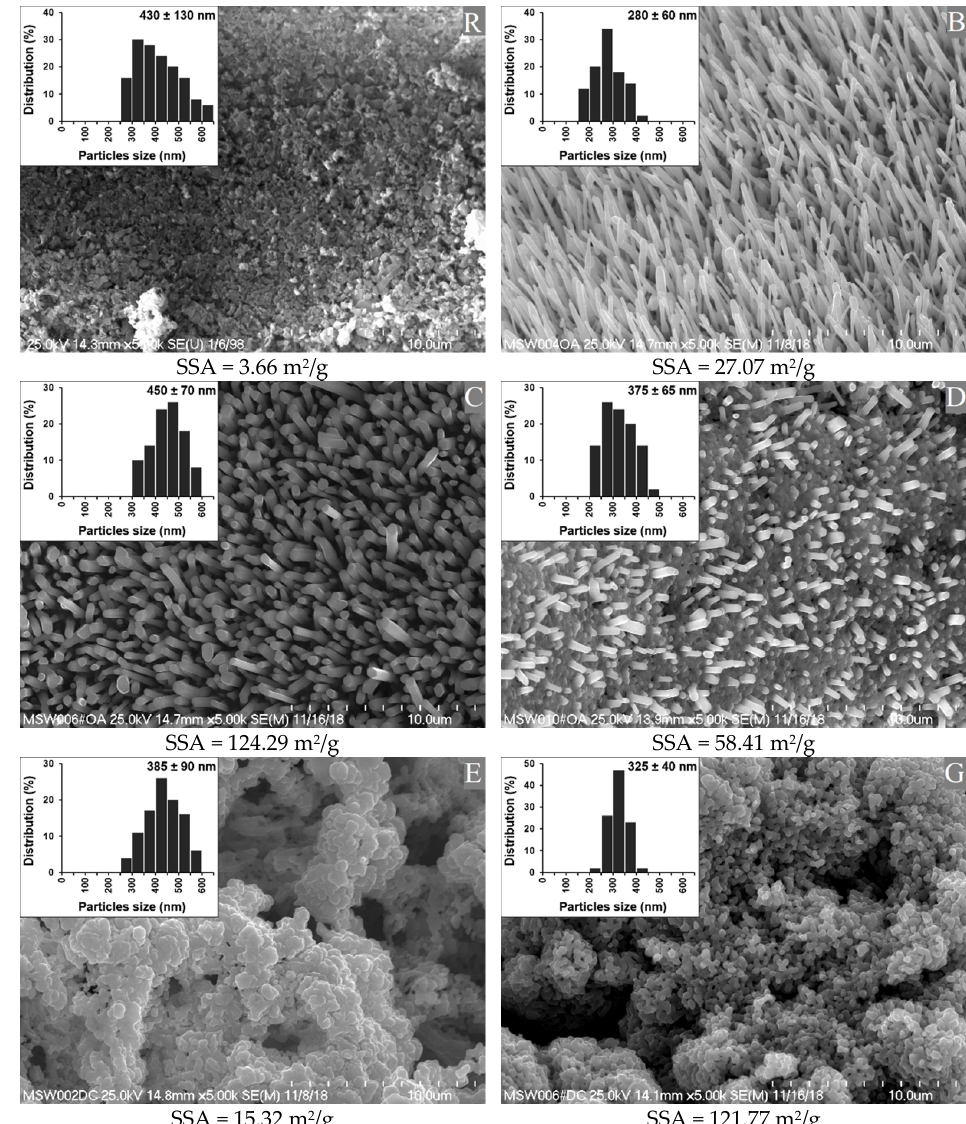
Figure 1. Morphology, specific surface area (SSA), and particle size of the reference (R) ZnO and the synthetized n-ZnO powders (B, C, D, E and G).